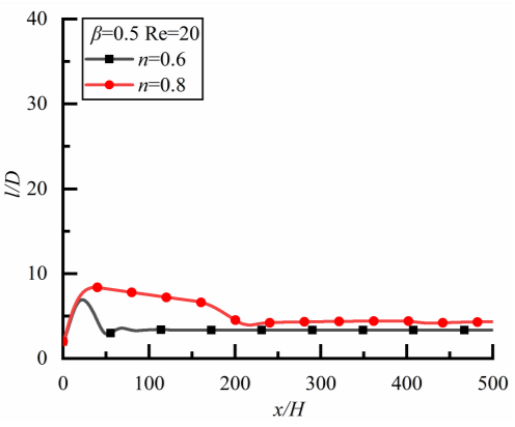
Figure 13. Relationship of particle spacing l/D.